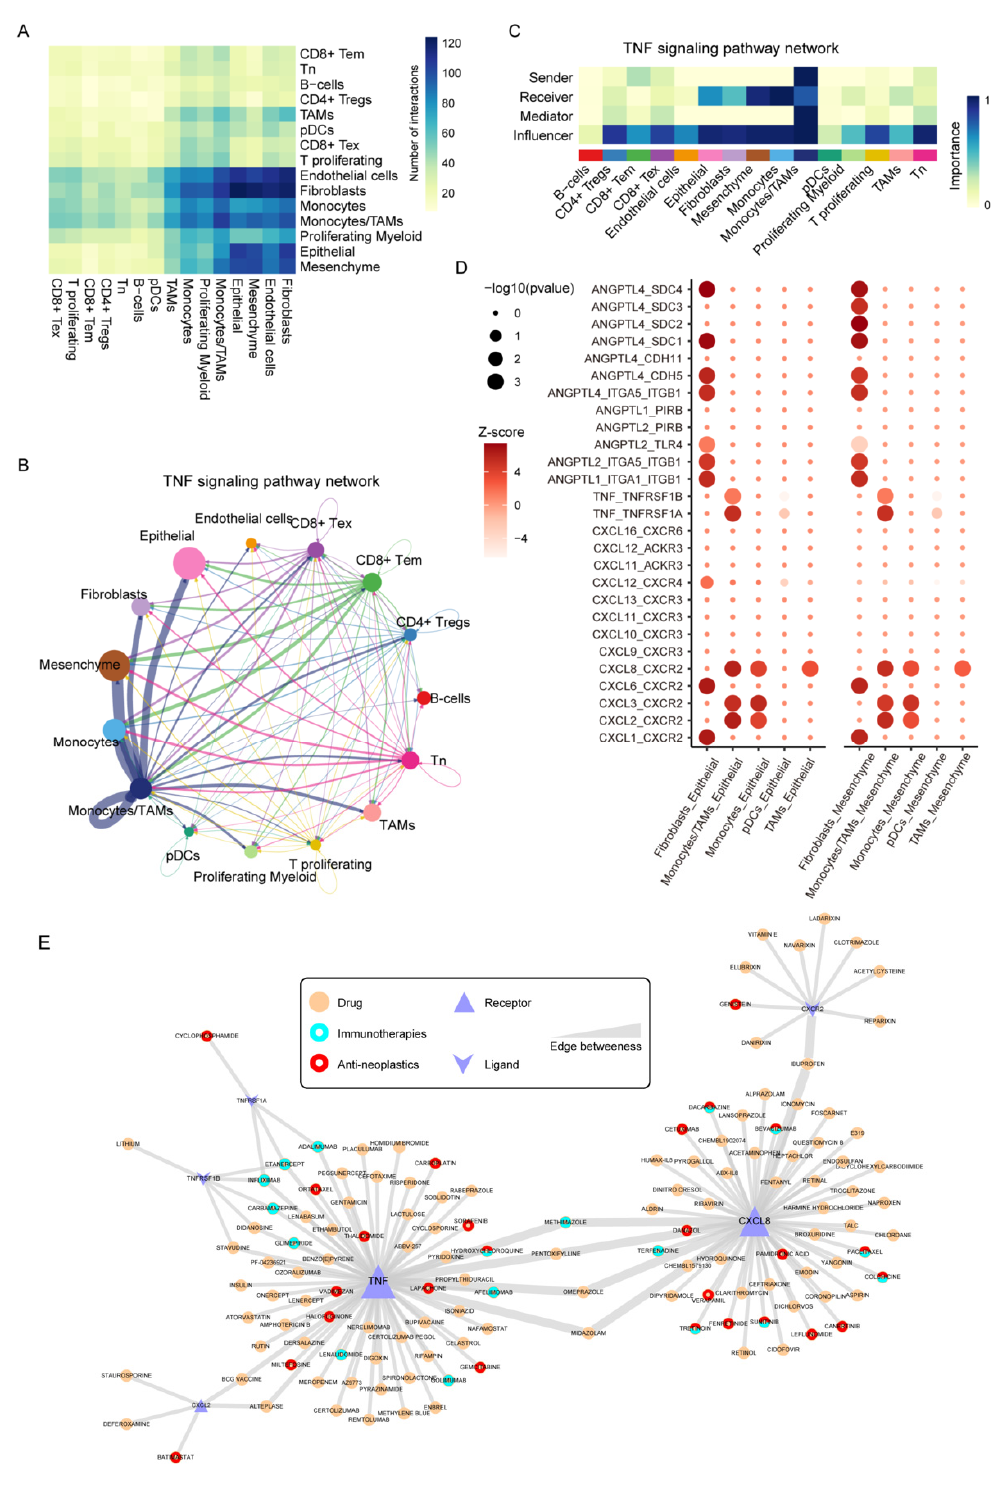
Figure 7. Cell-cell ligand-receptor network analysis. ( A ) Intercellular interactions across microenvi- ronment cells in TNBC. ( B ) Circle plots displaying the inferred network of the TNF signaling pathway. The edge width is proportional to the inferred communication amount. ( C ) Heatmap showing the relative importance of each cell group based on the computed four network centrality measures of TNF signaling. ( D ) Bubble plot showing the ligand-receptor between malignant cells and fibroblasts, monocytes, TAMs, and pDCs. ( E ) Network showing the potential drugs for TNF-related L-R pairs.